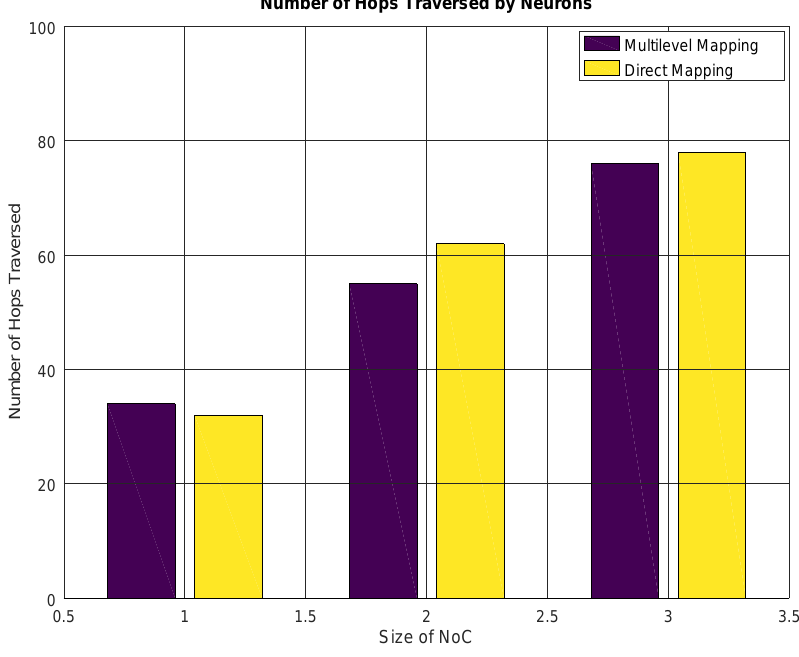
Figure 18. Number of hops traversed by neurons.